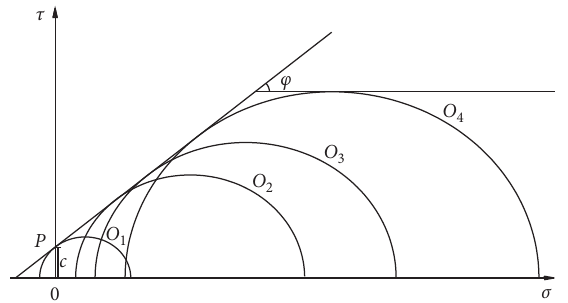
Figure 10: Relationship between rock bearing capacity composi- tion and ultimate stress circles.